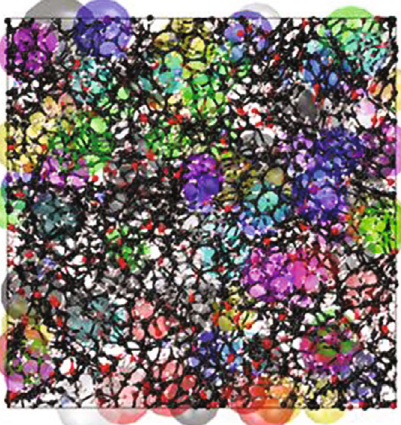
Figure 3: Visual illustration of the PSD algorithm for one of the kerogen structures [82].